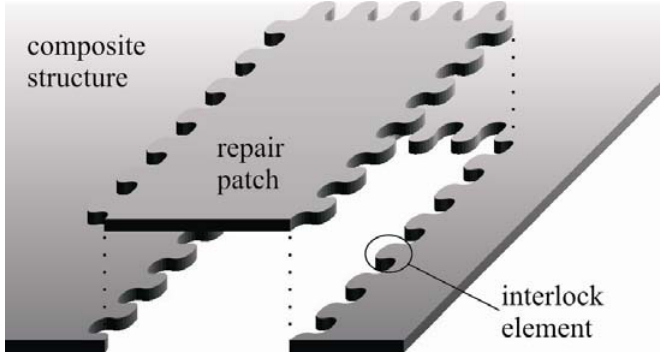
Figure 1. Novel interlock composite repair